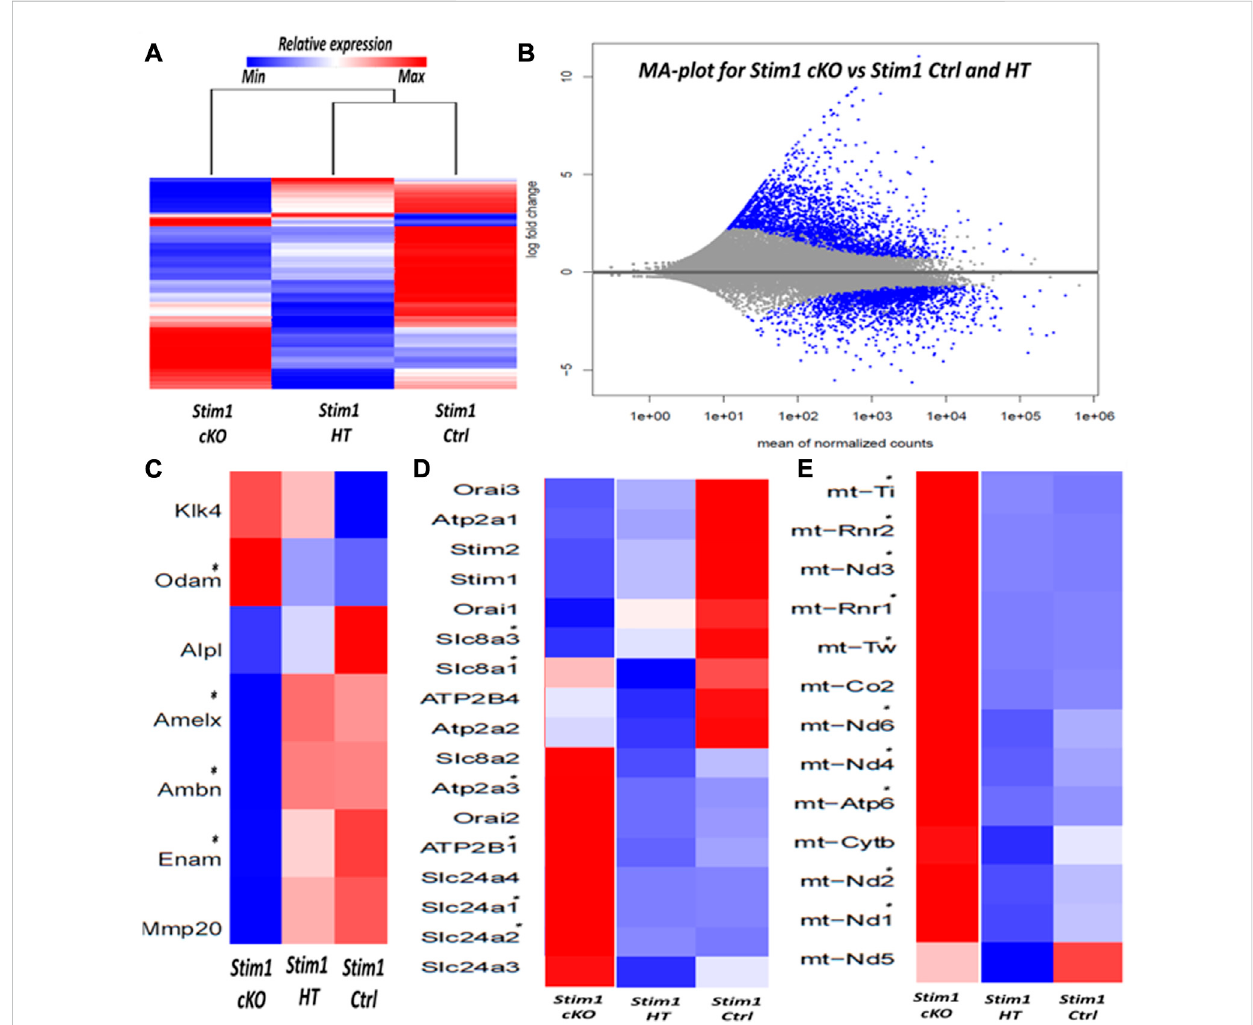
FIGURE 6 RNA sequencing of enamel organ cells in Stim1 cKO incisors mice highlights changes in enamel proteins and mitochondrial pathways (A) Heatmap and dendrogram showing clustering of samples with similar gene expression, the genetic pro fi le of Stim1 HT was closely correlated to Stim1 Ctrl (B) MA plotofmagnitude ofdifferential geneexpressioninStim1 cKOcomparedtoboth Stim1 HTandStim1 Ctrl (shownas thelog base2 ofmagnitude ofmean expression difference on the y -axis versus the mean of normalized counts on the x -axis). The differentially expressed genes (adj. p < 0.01, absolute foldchangeofmorethan2)areshowninblue. (C) Heatmapbasedontheexpressionofenamelgenes.Cleardifferencesinexpressioncanbeobservedin AmelX, Ambn, Enam and Odam in Stim1 cKO compared to both Stim1 HT and Stim1 Ctrl. No clear differences were found between the Stim1 HT and Stim1Ctrlintheexpression ofthemainenamelgenes (D) Heatmapbasedontheexpressionofgenesinvolvedincalciumtransport.Severaldifferencesin expression can be observed in genes encoding the calcium pumps SERCA3, PMCA1 in addition to the calcium exchangers NCKX1 and NCKX2 in Stim1 cKO compared to both Stim1 HT and Stim1 Ctrl. NCKX4 was also upregulated in Stim1 cKO mice with an adjusted p -value that is near signi fi cance (adj. p < 0.05) (E) A heatmap showing the expression levels of several mitochondrial RNA ’ s. Of interest, expression of several NADH dehydrogenase and cytochrome oxidase subunits were upregulated in Stim1 cKO amelobalsts. No clear differences were found between the Stim1 HT and Stim1 in the expressions of most of these mitochondrial subunits (*adjusted p <